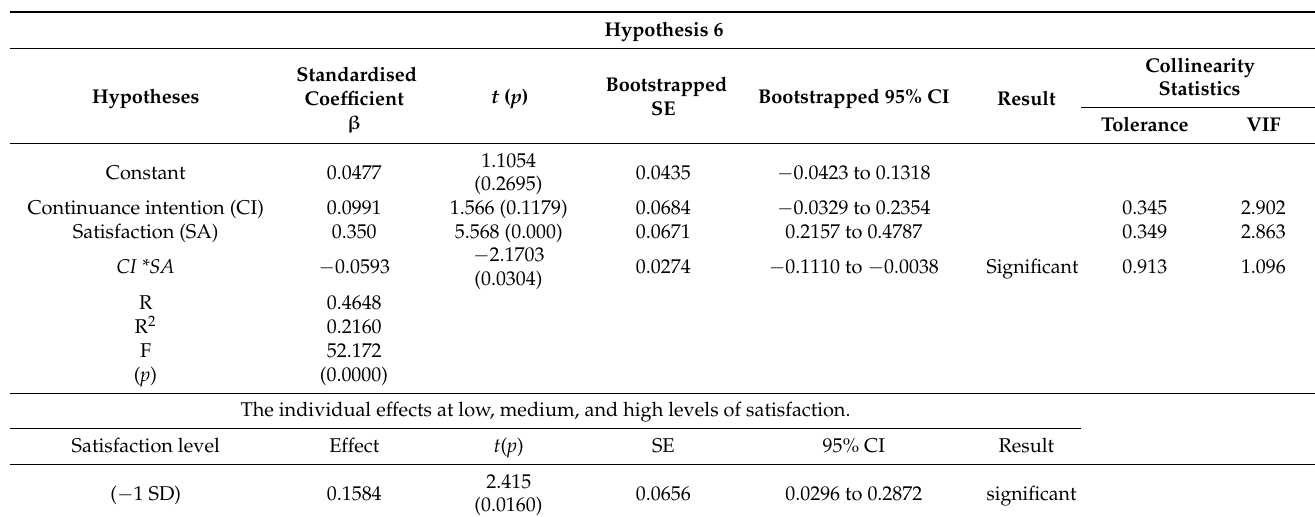
Table 9. Moderator regression analysis (testing hypothesis